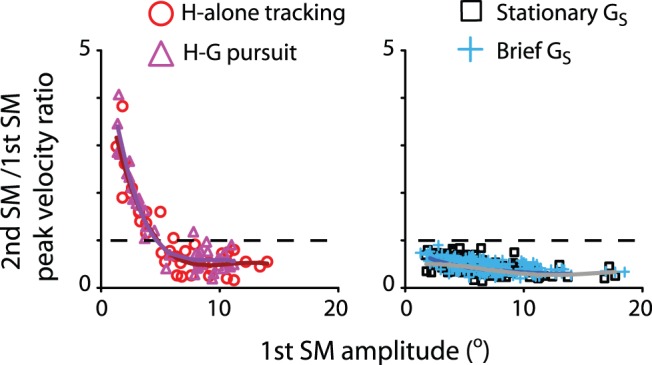
Head tracking movements and eye-head combined gaze shifts distinguished by the peak velocity ratio between the second and the first submovements as a function of submovement amplitude.The regression lines are least-square functions. The horizontal dashed lines indicate when the second submovements had the same values in peak velocity as the first submovement. Data includes only overlapping submovements.